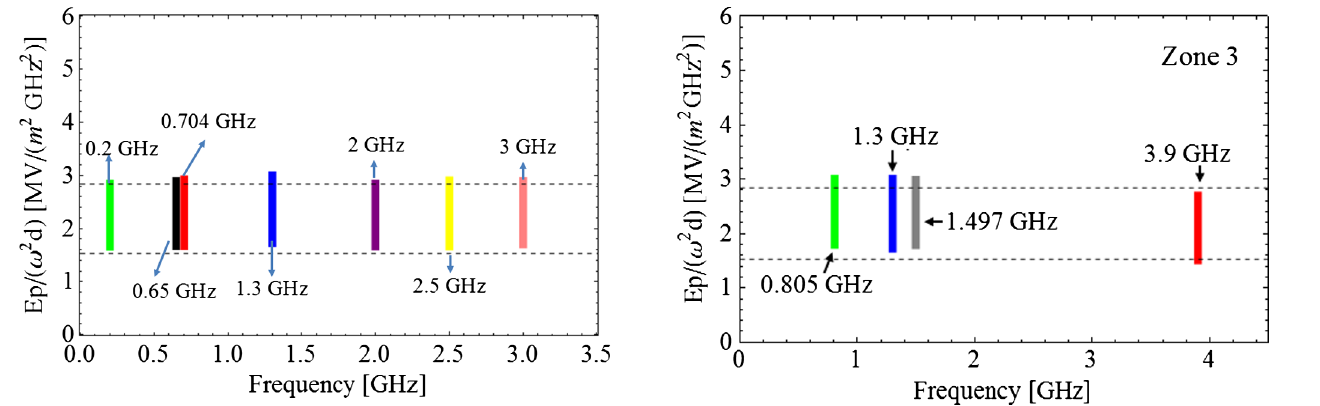
FIG. 16. Frequency scaling of zone 3 MP in HOM couplers of real cavities. The dashed lines are the lower and upper bound for analytical prediction for two-plane first-order MP based on the parallel-plate model.